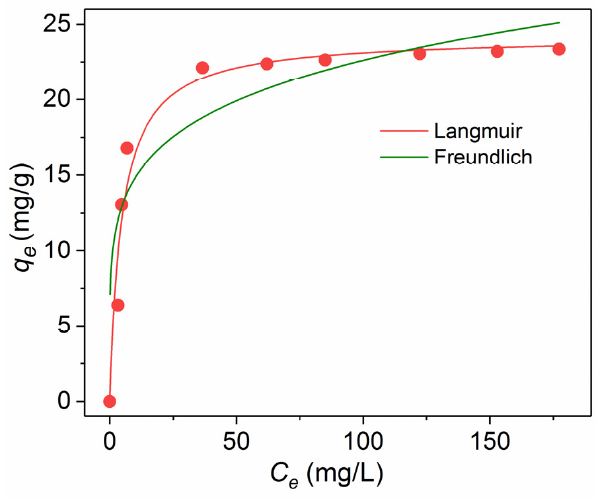
Figure 11. Adsorption isotherms of CR on magnetic NPs at 25 °C. Table 2. Adsorption isotherm parameters (Equations (5) and (6)) for Congo red at 25 ° C. Langmuir Model